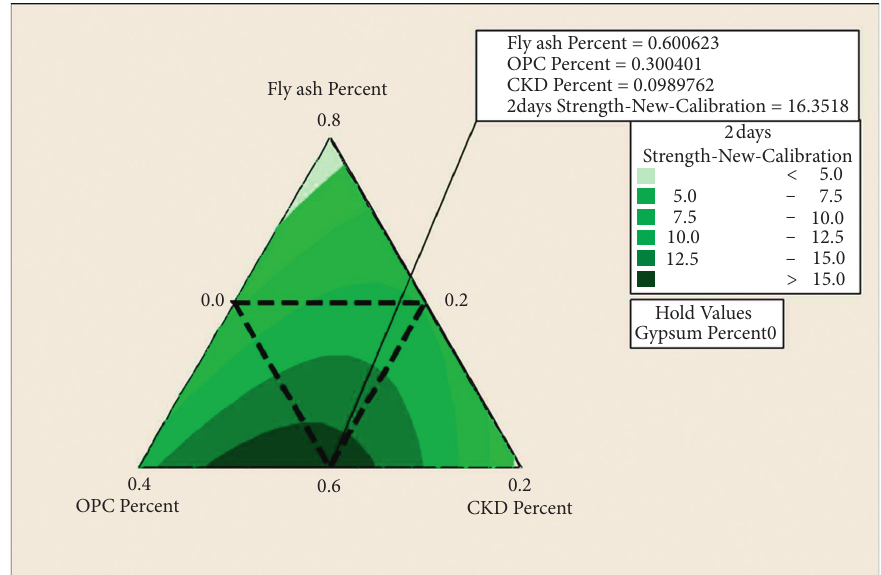
Figure 16: Proportion optimization of a HVFA paste based on 2d compressive strength, reproduced from [126], with permission from Elsevier,